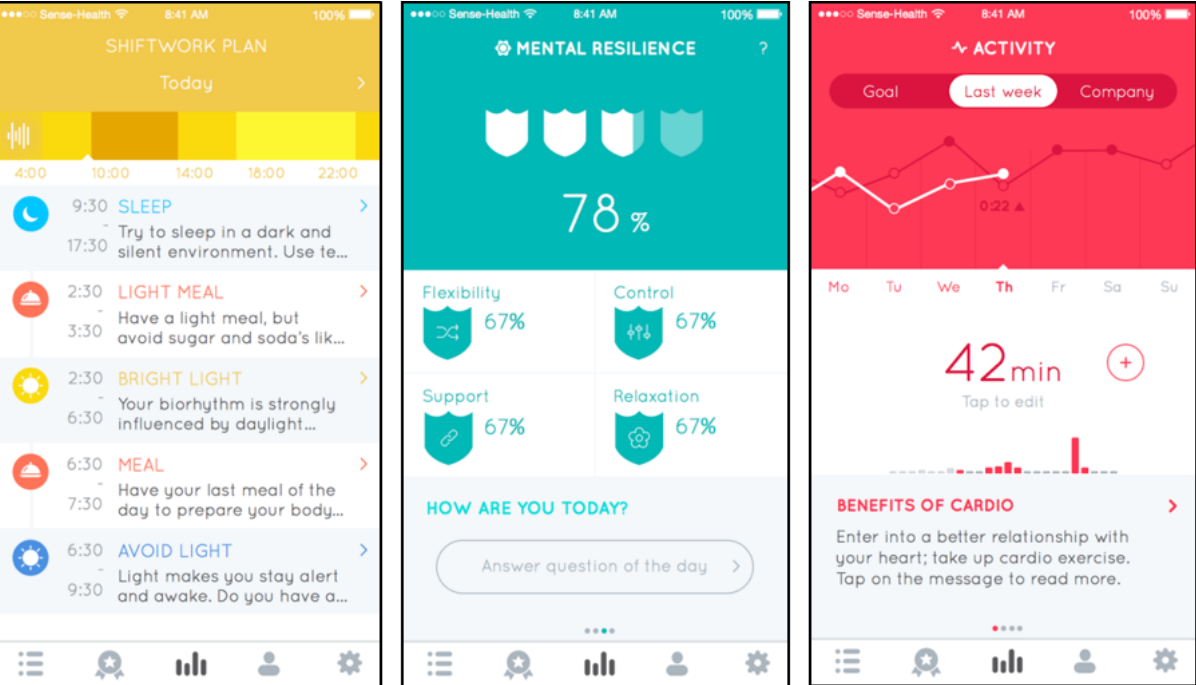
Figure 1. Brightr, examples of the shiftwork, mental resilience, and physical activity